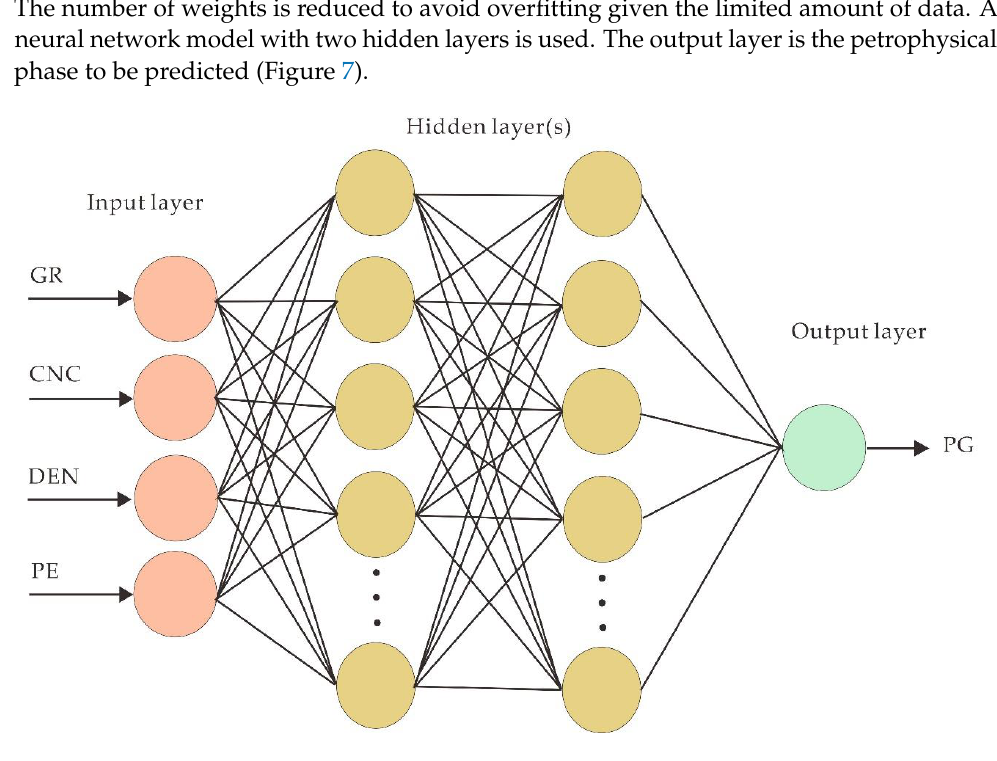
Figure 7. A schematic diagram of the ANN structure.